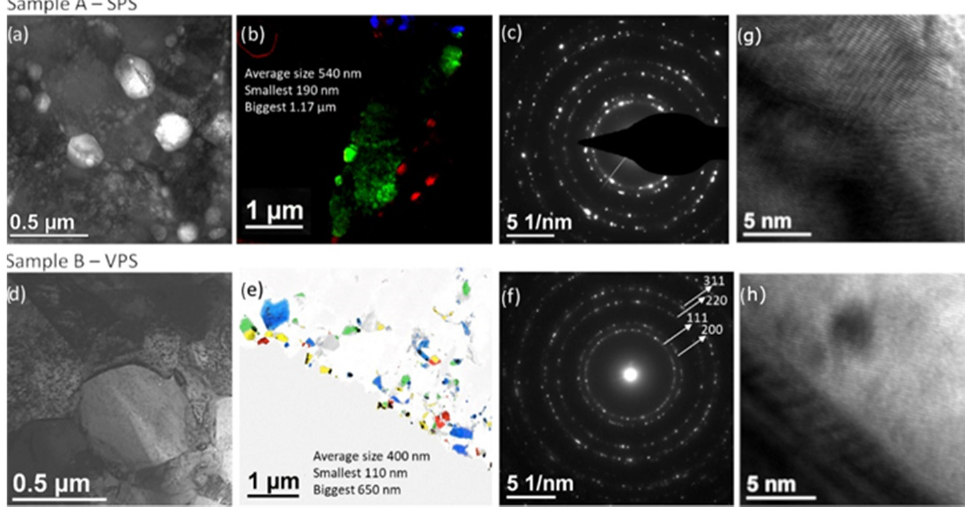
Figure 7. TEM bright field images of the samples ( a , d ), many dark field images of the coatings superposed with different colors showing the different orientations and the grain size ( b , e ), SADP of each sample showing in both cases the pure palladium ( c , f ), and HRTEM ( g , h ).